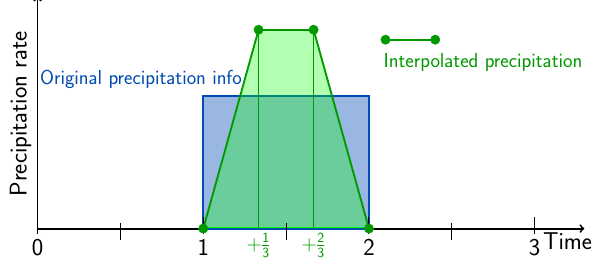
Figure 3. Precipitation rate linearly interpolated using a sub-grid with two additional points. Colours as in Fig. 1.